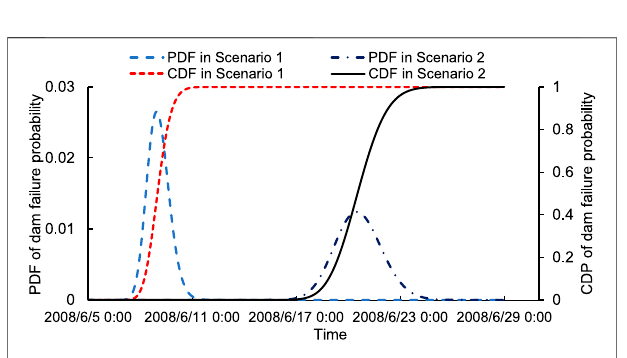
FIGURE 9 | PDF and CDF of P f in the two